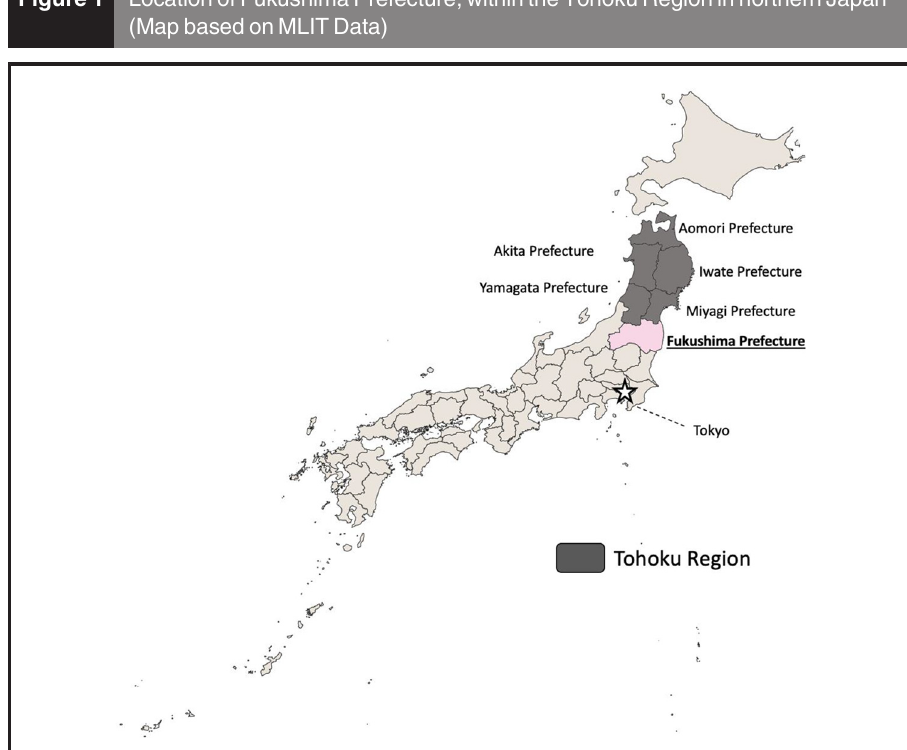
Figure 1 Location of Fukushima Prefecture, within the Tohoku Region in northern Japan (Map based on MLIT